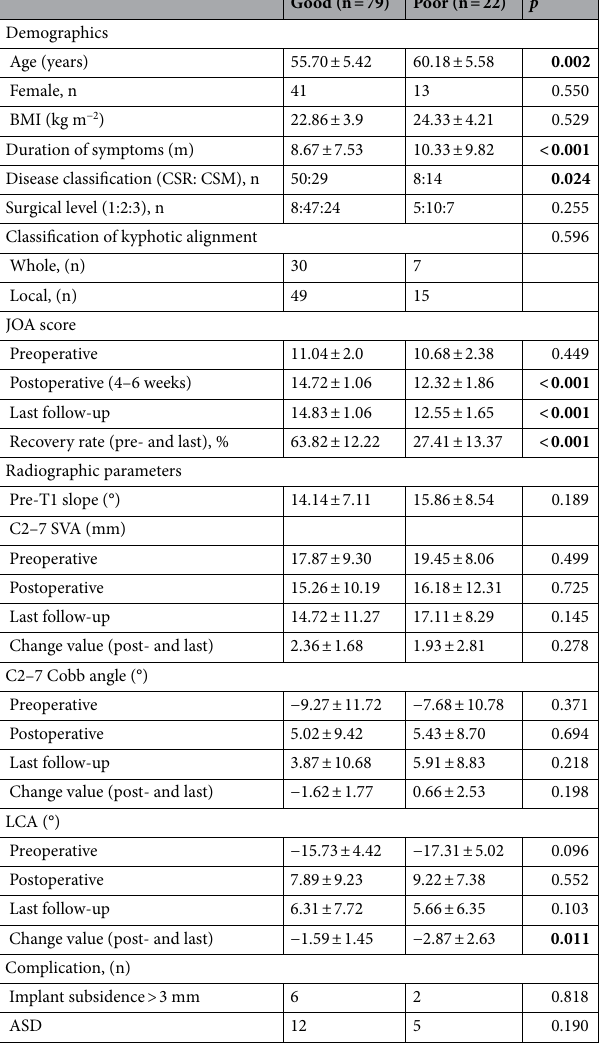
Table 1. Comparison of patient characteristics between good group and poor group. BMI body mass index, CSR cervical spondylotic radiculopathy, CSM cervical spondylotic myelopathy, JOA Japanese